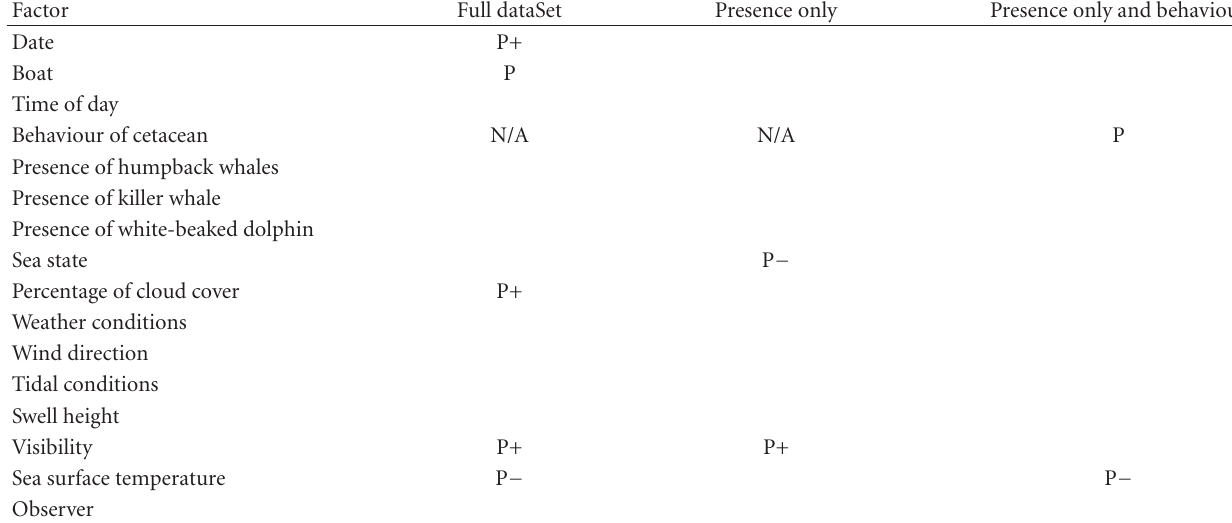
Table 2: Factors present in the stepwise-reduced model for each dataset where significant multiple linear regressions were obtained. P indicates that the factor was present in the reduced model, and + or − indicates whether there was a positive or negative relationship of the factor compared to the number of Cetaceans. Where no + or − is present, the factor was a category variable. N/A indicates that this variable was not used as an explanatory factor in the